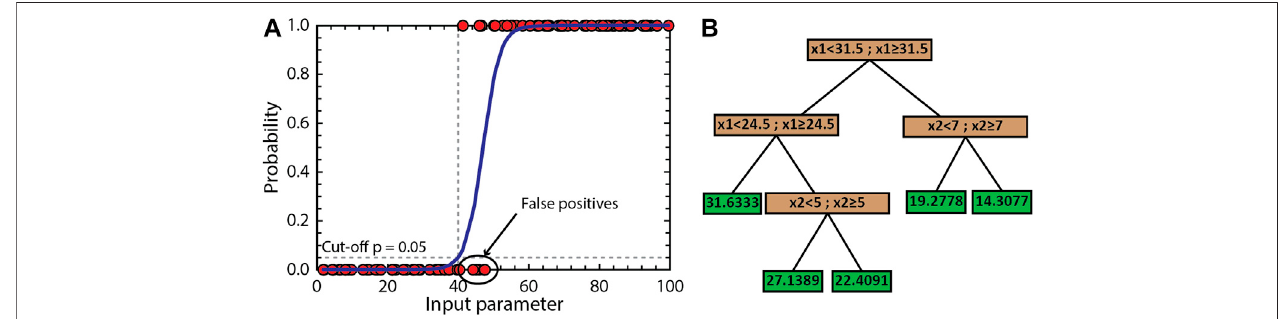
FIGURE 3 | Schematic examples of the machine learning methods used in MushPEC. (A) Logistic regression of a simple one-variable system. Filled red circles correspond to the observations used as training set. Blue line is the logistic function modelled to explain the data. The cut-off probability is set to 0.05 to minimize false negatives, which in turn maximizes false positives. (B) Example of regression tree modi fi ed from MathWorks documentation for a system with 2 variables (x1 and x2). Brown boxes correspond to the branches that de fi ne the partitioning conditions, and the green boxes correspond to the leaves or nodes that assign the response value.